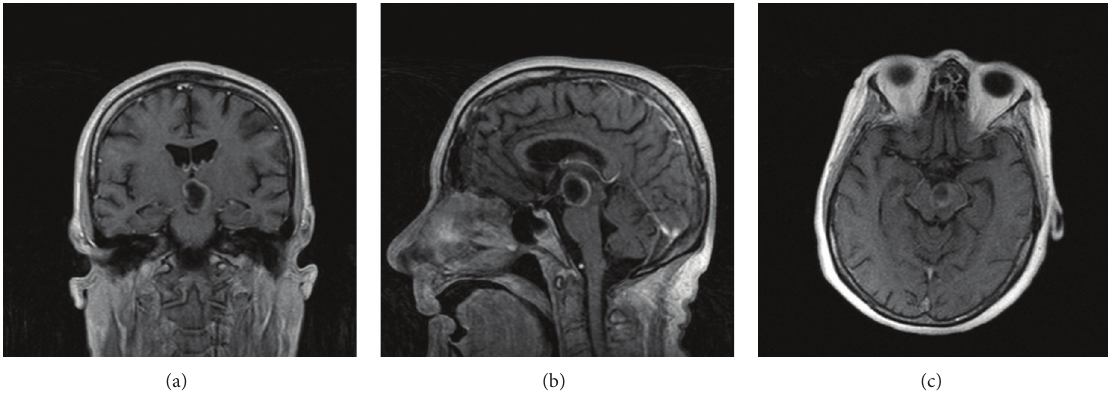
Figure 1: Cystic metastasis. Rim-enhancing hypointense mesencephalic lesion revealed by postcontrast T1-weighted MRI images ((a): coronal, (b): sagittal, and (c): axial slices). Department of Neurology, Colentina Clinical Hospital brain imaging archive.